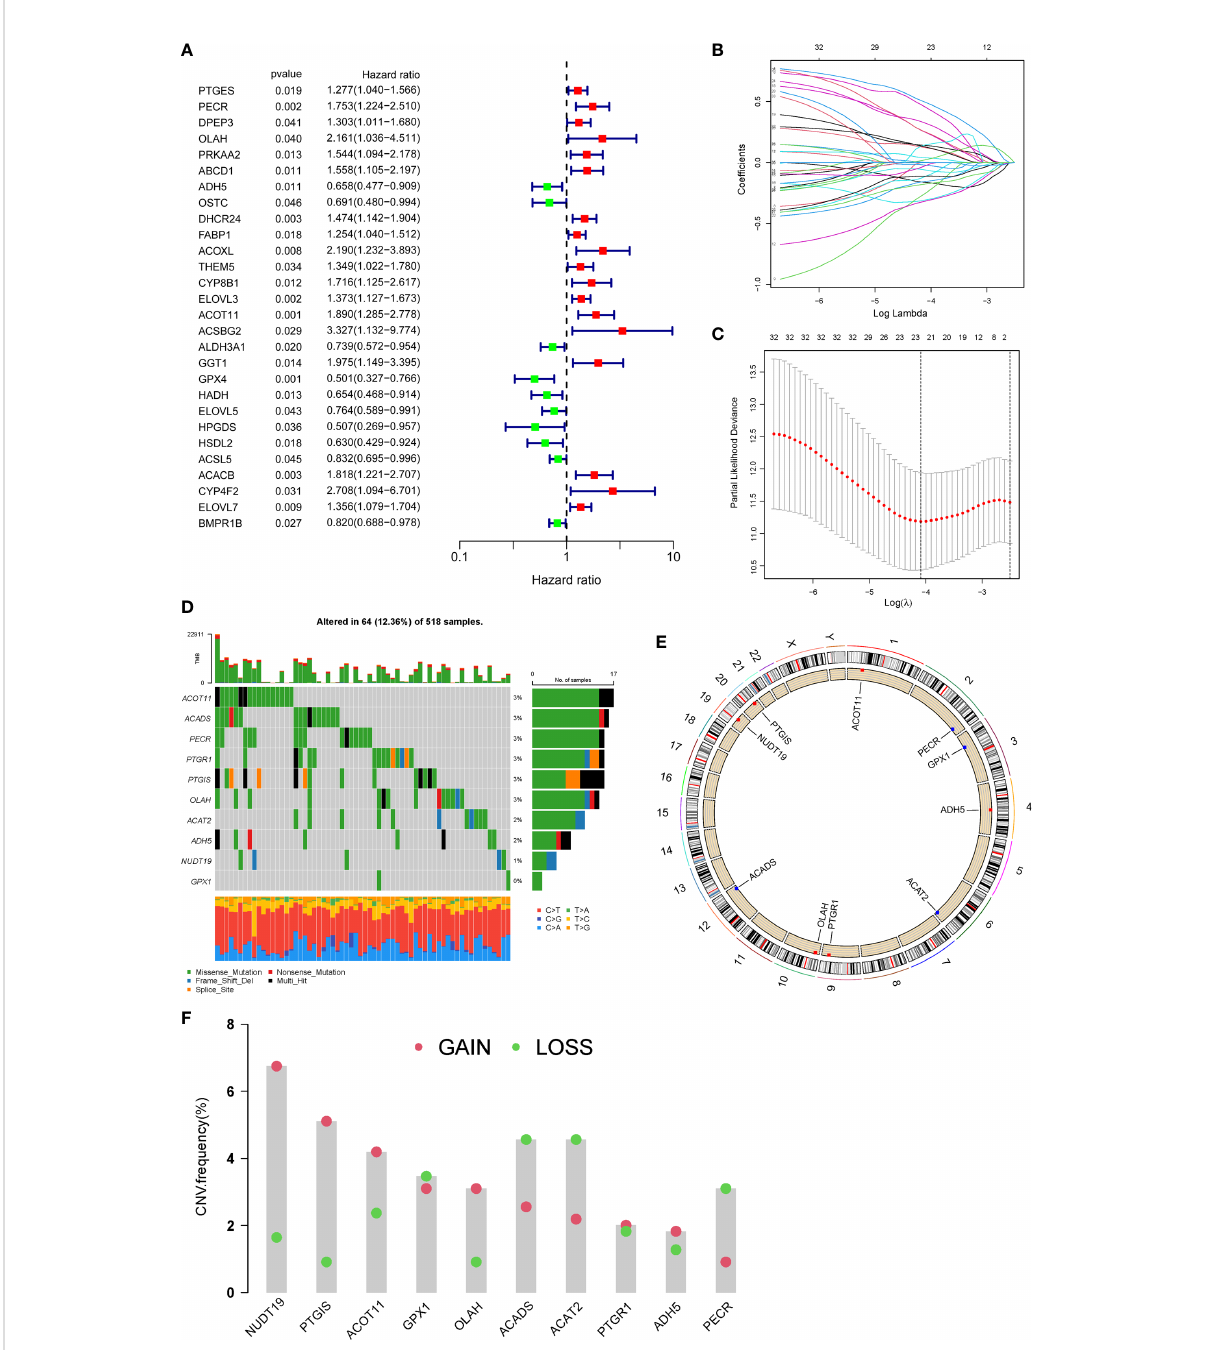
FIGURE 2 Identi fi cation of prognostic FAMGs and their characteristic analysis. (A) Forrest plot of 28 FAMGs related with prognosis by univariate regression analysis. (B) LASSO regression analysis. (C) Partial likelihood deviance for LASSO regression. (D) Pro fi les of genetic mutation in UCEC patients. (E) CNV alteration of FAMGs on chromosomes. (F) Frequencies of CNV gain, loss, and non-CNV among FAMGs. FAMGs: fatty acid metabolism-related genes. LASSO: least absolute shrinkage and selection operator. UCEC: Uterine corpus endometrial carcinoma. CNV: copy number variation.